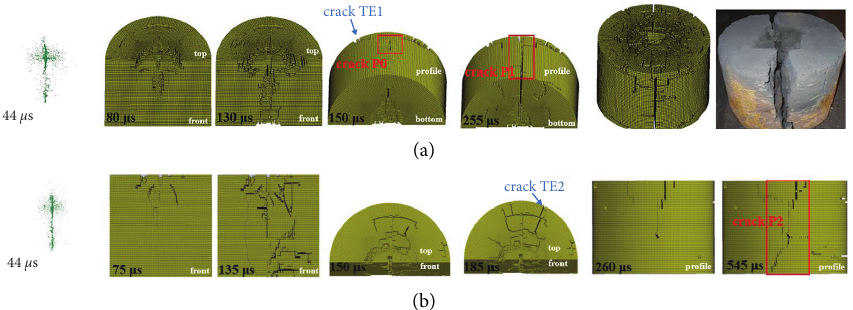
Figure 4: The process of fracture formation. (a) Case 1. (b) Case 2.